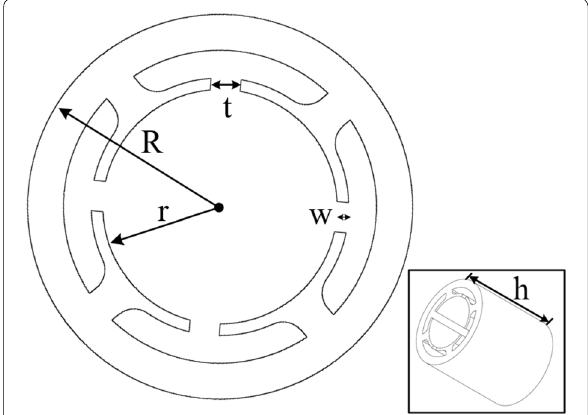
Fig. 1 Schematic of the magnetron-type microwave